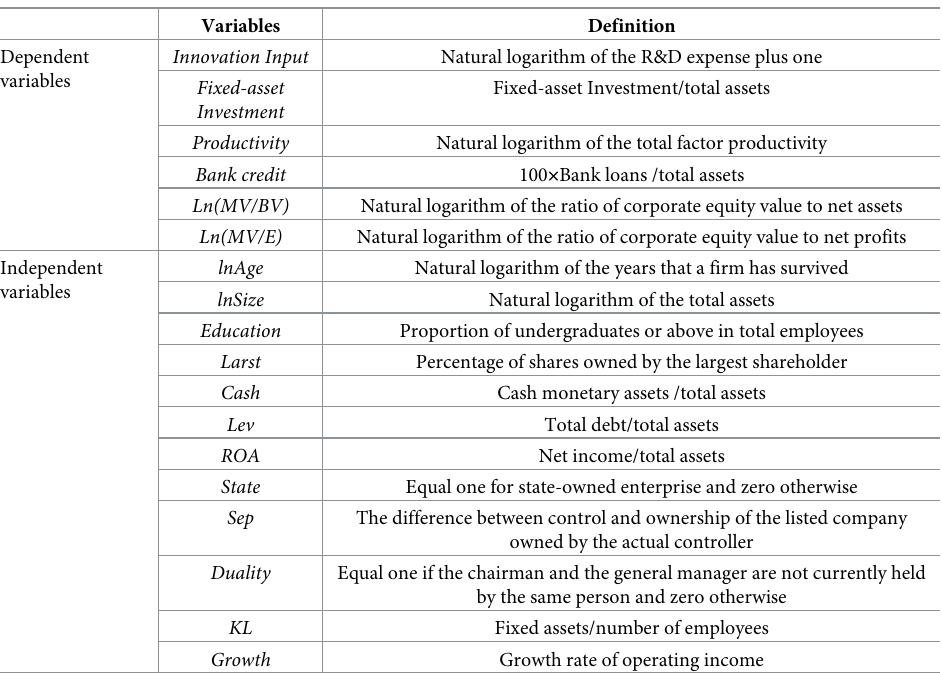
Table 1. Variable